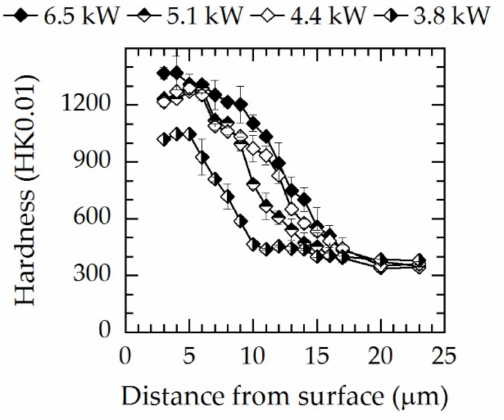
Figure 8. Microhardness–depth profiles for three di ff erent screen powers for N 2 :H 2 = 1:1; T = 733 K; t = 5 h. The lines are a guide for the